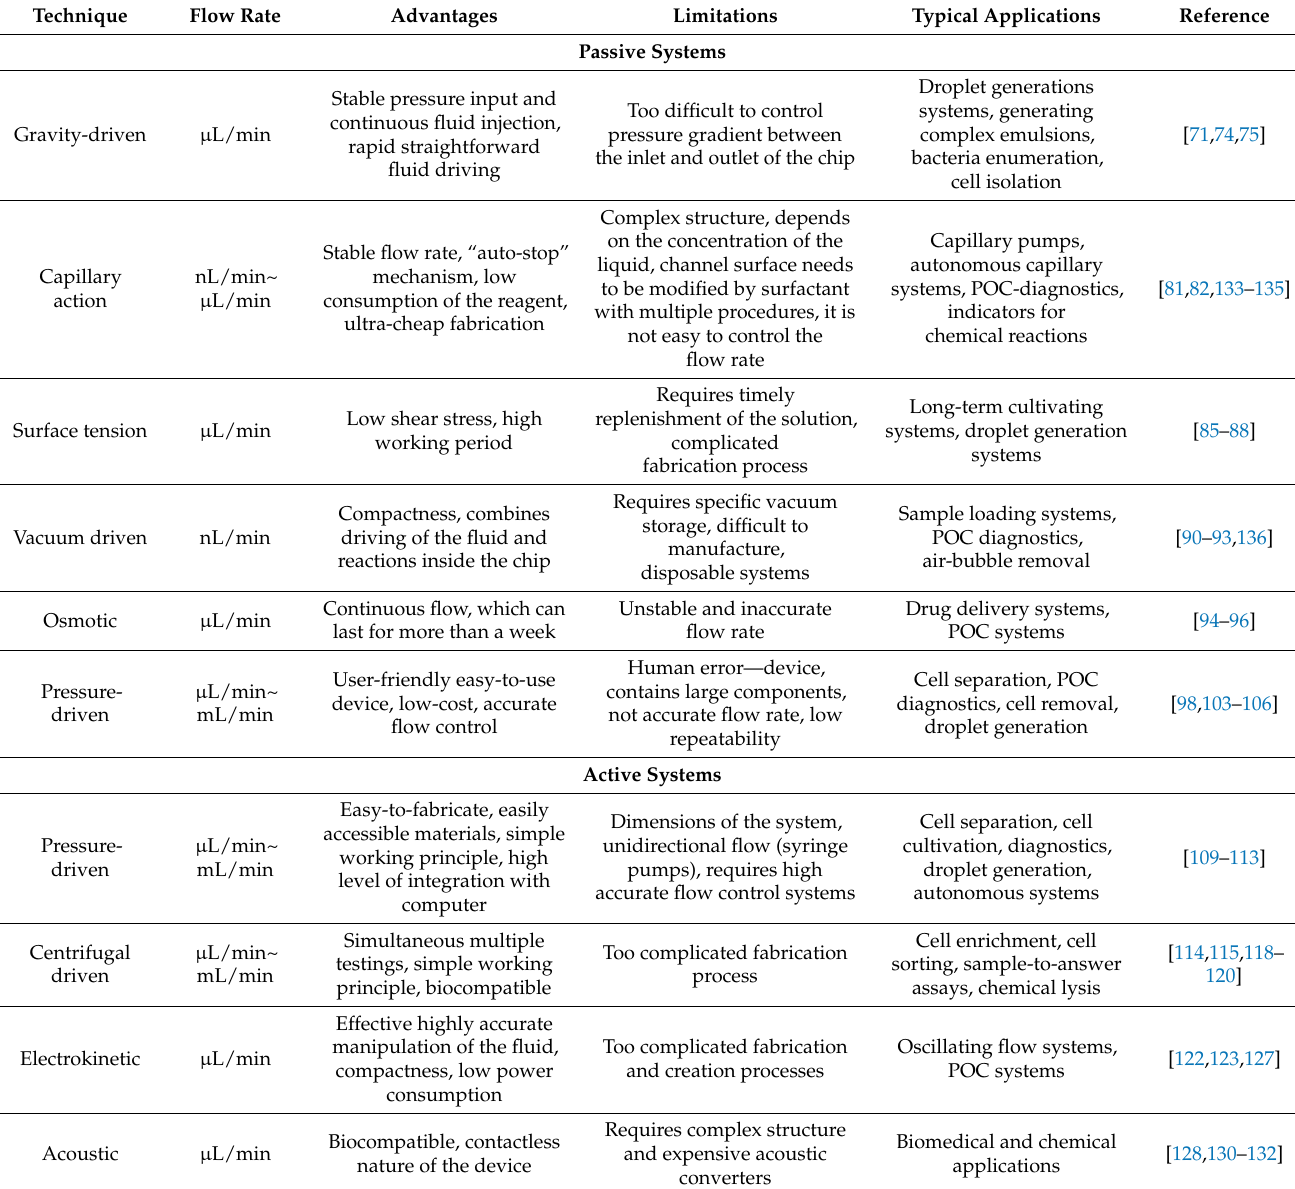
Table 2. Comparison of different techniques for flow control in microfluidic